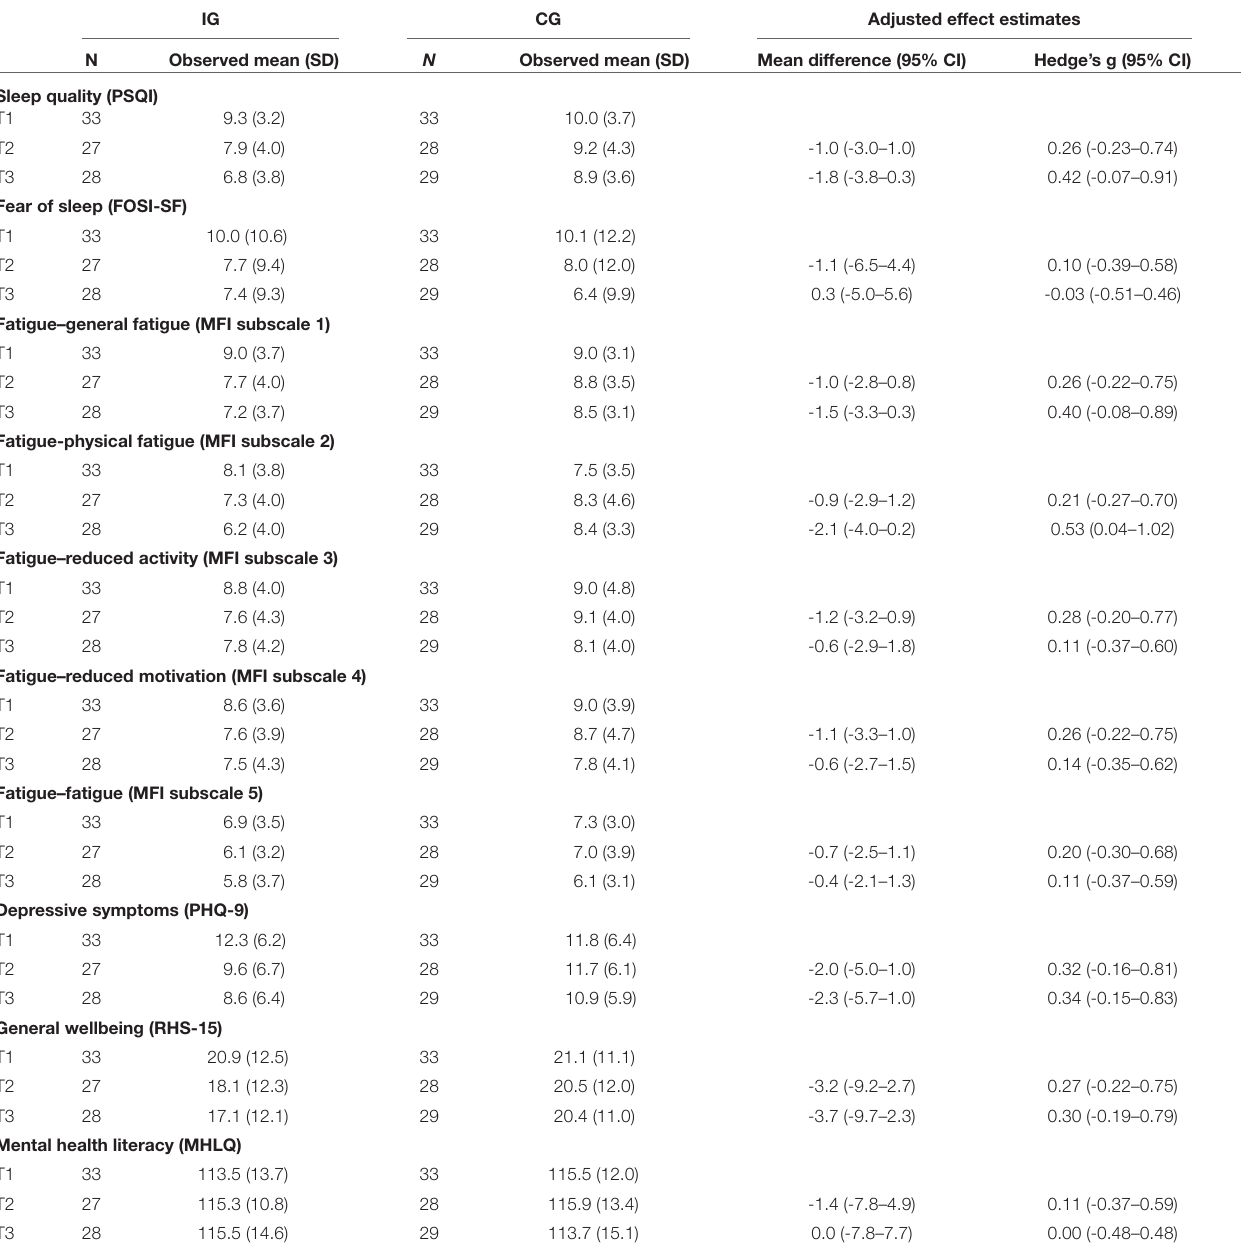
TABLE 4 | Results for the secondary